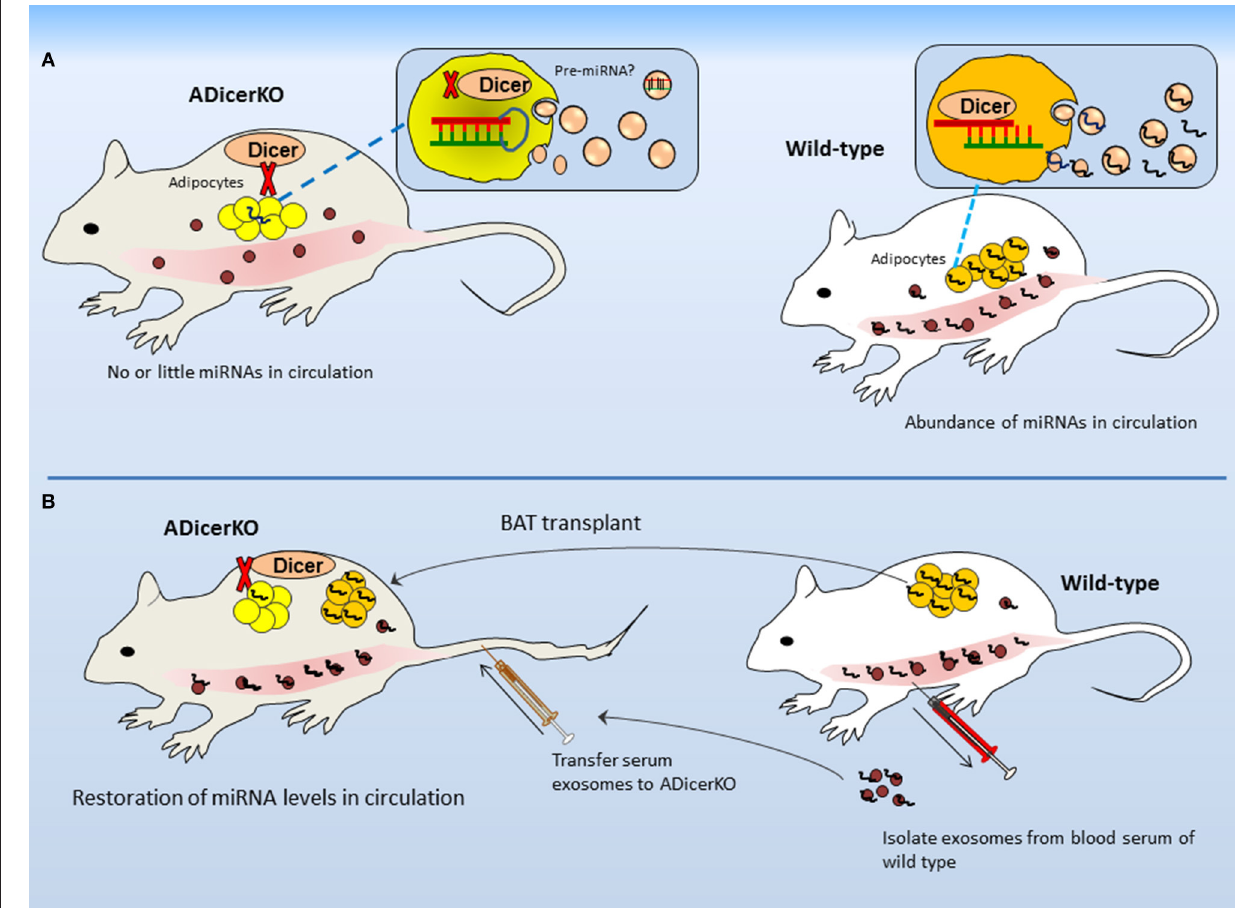
FIGURE 2 | Adipose is major source of circulating microRNAs. (A) Differences in secreted miRNAs between ADicerKO and wild-type mice. Although numbers of circulating-exosomes are the same in both, however the amount of miRNAs in exosomes from ADicerKO is far less; that is due to Dicer deficit. (B) Transplant of brown adipose and serum exosomes from wild-type to ADicerKO-mice reconstitutes miRNA